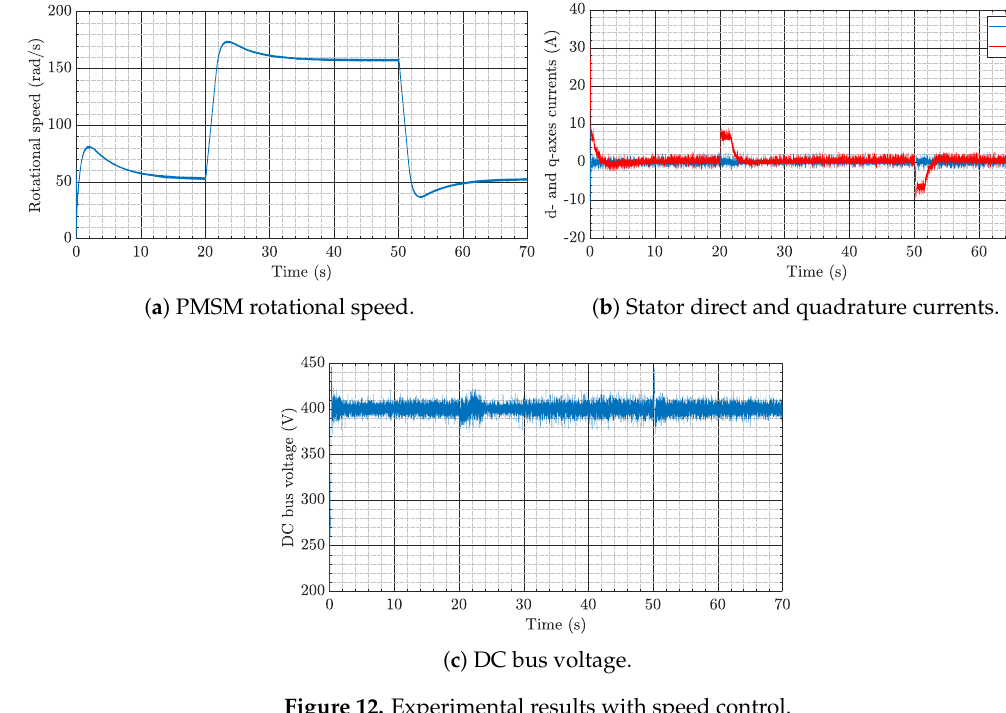
Figure 12. Experimental results with speed control.